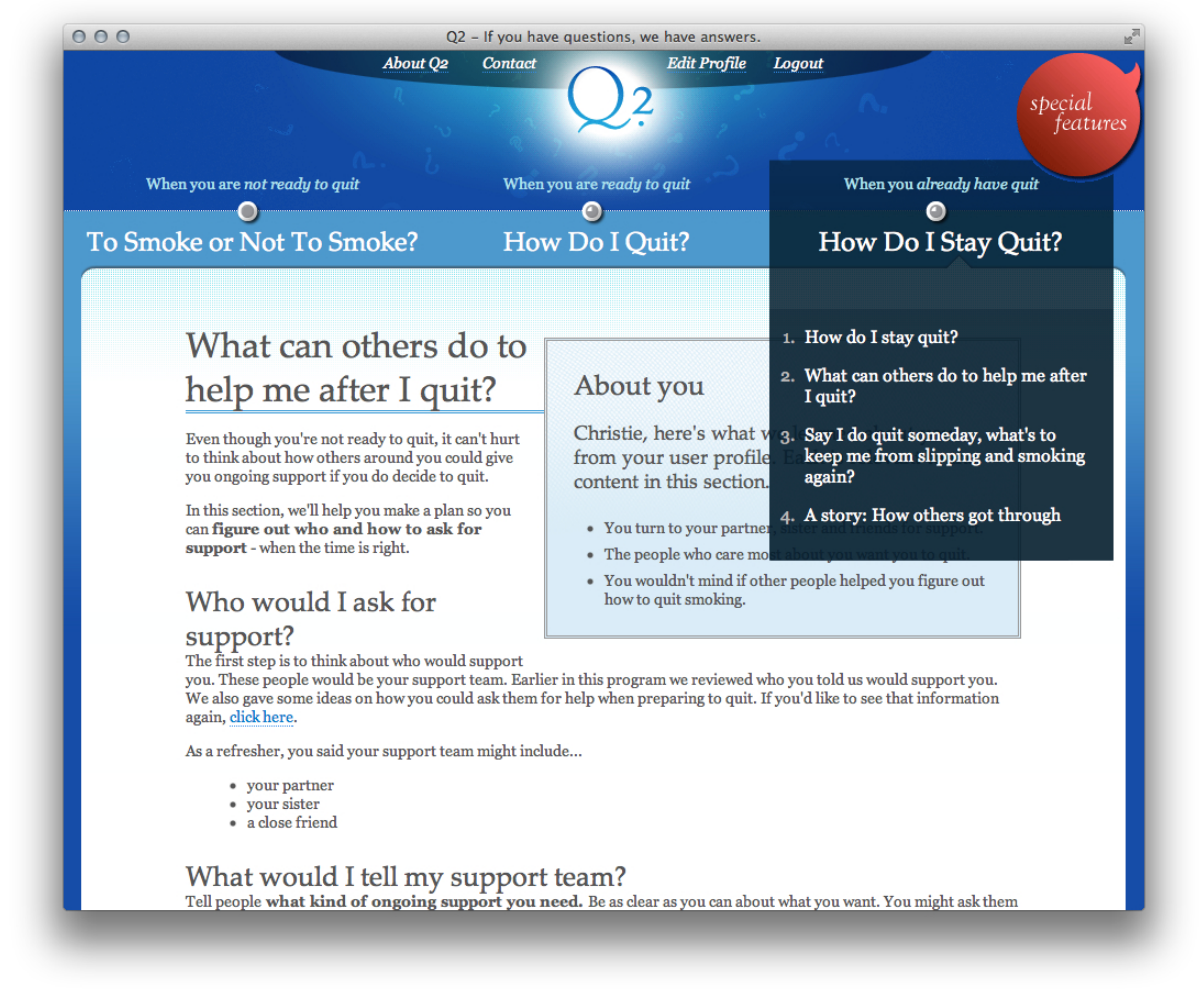
Figure 1. Example screenshot of Questions about Quitting (Q2)